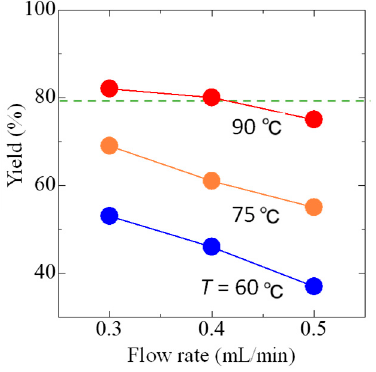
ff ects of reaction temperature and flow rate on Figure 5. Effects of reaction temperature and flow rate on yield. Figure 5. E Figure 5. Effects of reaction temperature and flow rate on yield.